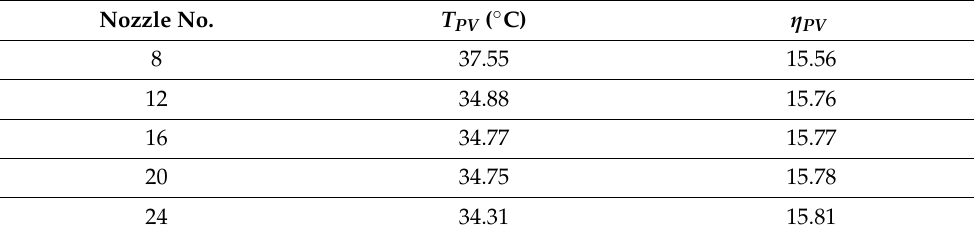
Table 6. Effect of number of IJs on the PV temperature and PV efficiency at c = 2%, I = 1000 W/m 2 , h sl = 107.1 kJ/kg, ˙m = 0.12 kg/s, and H = 30 mm. Nozzle